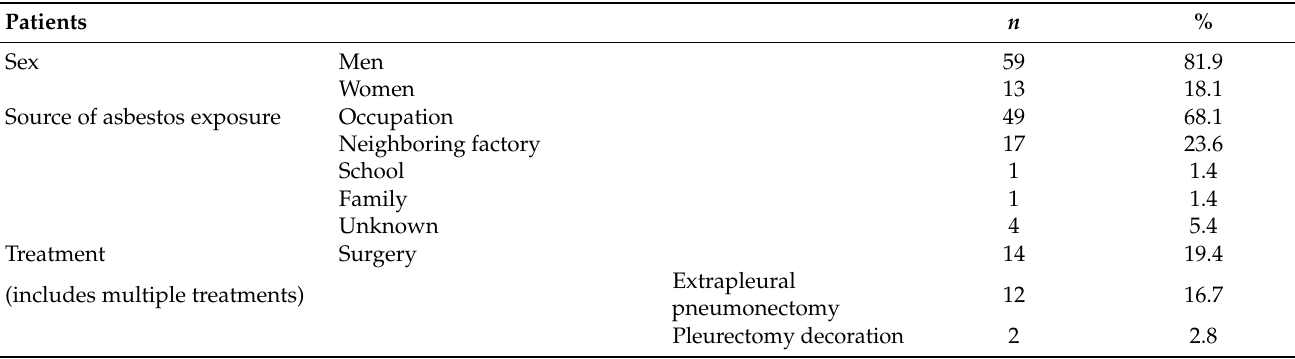
Table 1. Characteristics of malignant pleural mesothelioma patients and their participating bereaved family members ( n =